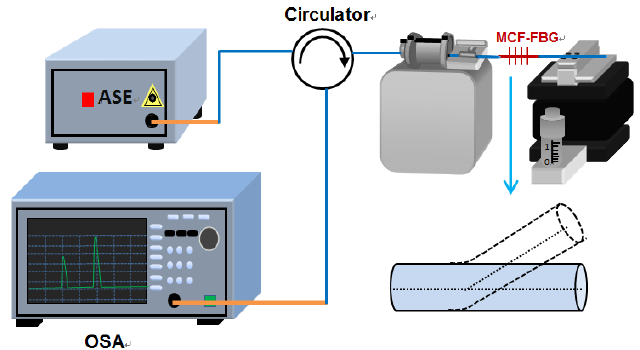
Figure 4. Schematic diagram of MCF-FBG as a displacement sensing system.